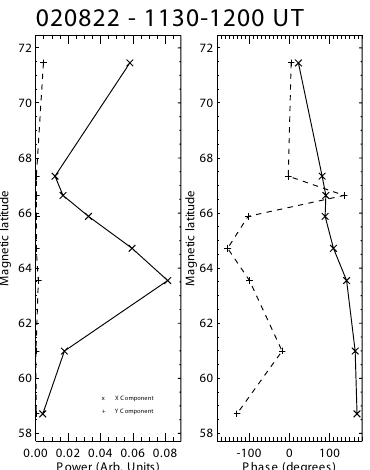
Fig. 9. Latitude profile of the Fourier power and phase of the domi- nant peak (6.1mHz) as seen in the power spectra of X and Y compo- nents of IMAGE magnetometer data on 22 August 2002 for 11:30– 12:00 UT, as shown in Fig. 8. The diagram indicates that the power of the dominant peak maximises at around 63.5 ◦ magnetic latitude with a phase reversal at the site of maximum power, the signature of a field line